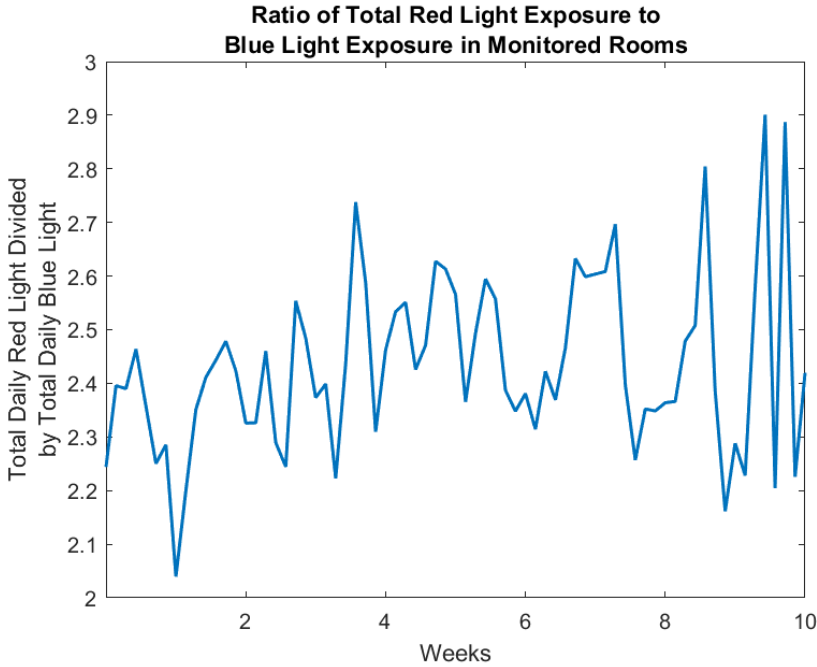
Figure 6. Ratio of daily in-home red light exposure in microwatts per square centimeter (600–700 nm) to daily in-home blue light exposure in microwatts per square centimeter (400–500 nm) summed from the four rooms of the home of the study participant, using only light values when motion was detected in the room.